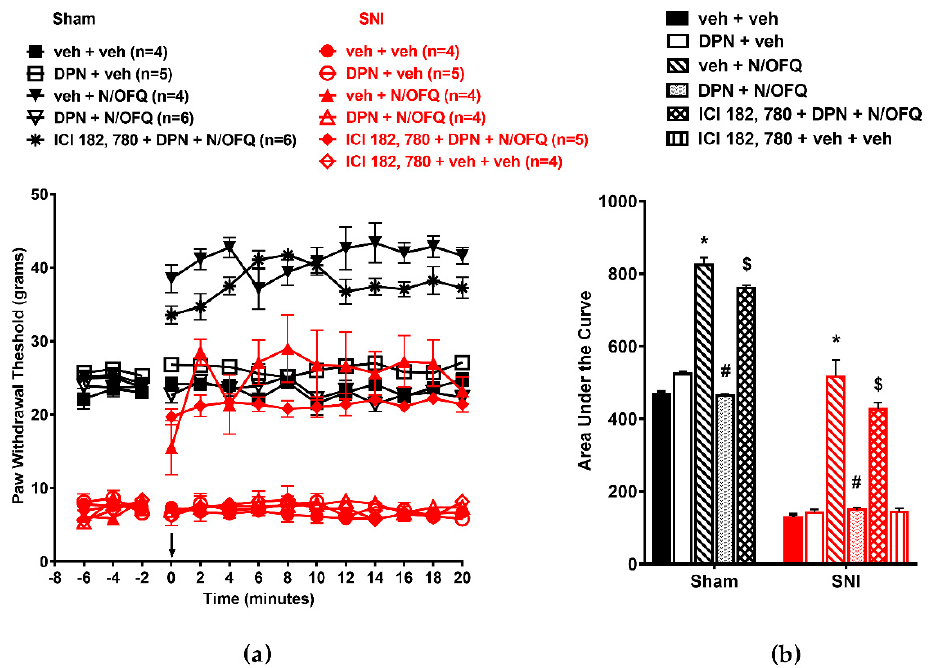
Figure 5. Selective activation of ER β attenuated NOP-mediated antihypersensitivity in OVX female rats: ( a ) SNI of the sciatic nerve significantly reduced PWTs compared to the sham group. Intrathecal administration of N / OFQ (10 nM) significantly increased paw withdrawal thresholds, and diarylpropionitrile (DPN) (100 nM), the selective ER β agonist, attenuated the N / OFQ-induced increase in PWTs. Pretreatment with mER antagonist (ICI 182,780) restored the N / OFQ-induced increase in PWTs. ( b ) AUC analysis confirmed these e ff ects, with a significantly reduced AUC in SNI groups, N / OFQ significantly increasing it, and DPN attenuating the e ff ect of N / OFQ in an antagonist-reversible manner. Here, * p < 0.05 compared to veh + veh; # p < 0.05 compared to veh + N / OFQ; $, p < 0.05 compared to DPN + N / OFQ.